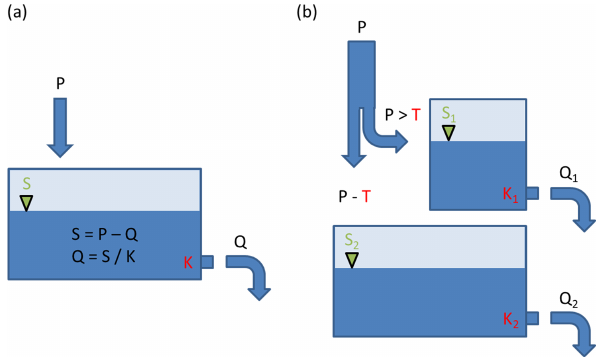
Figure 2. (a) Model-02, a single linear reservoir with state vari- able S and retention constant K . The reservoir is replenished by precipitation P and drained by discharge Q . (b) Model-03, with two linear reservoirs. Precipitation input is split by intensity thresh- old T